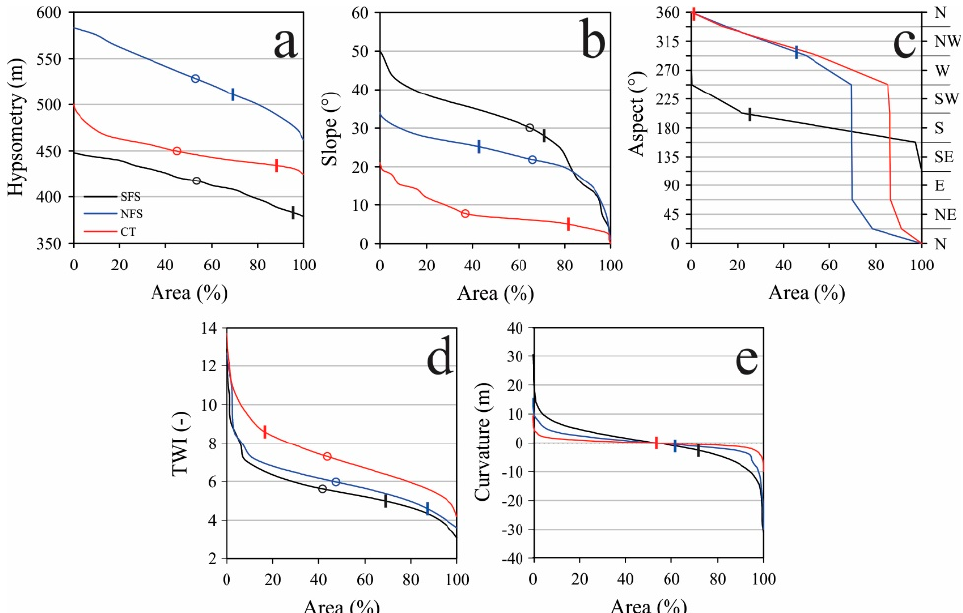
Figure 4. Topographic indices and morphometric analysis derived from a 5 m digital terrain model for the SFS, CT and NFS micro-basins and its relation with respective area: ( a ) hypsometry, ( b ) slope, ( c ) aspect, ( d ) topographic wetness index (TWI) and ( e ) curvature. Vertical solid lines represent morphometric values at soil moisture stations and circles represents mean morphometric values of each micro-basin.